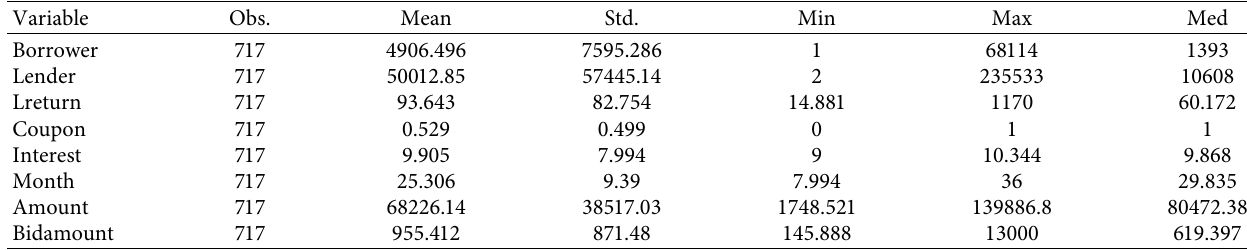
Table 7: Summary statistics.